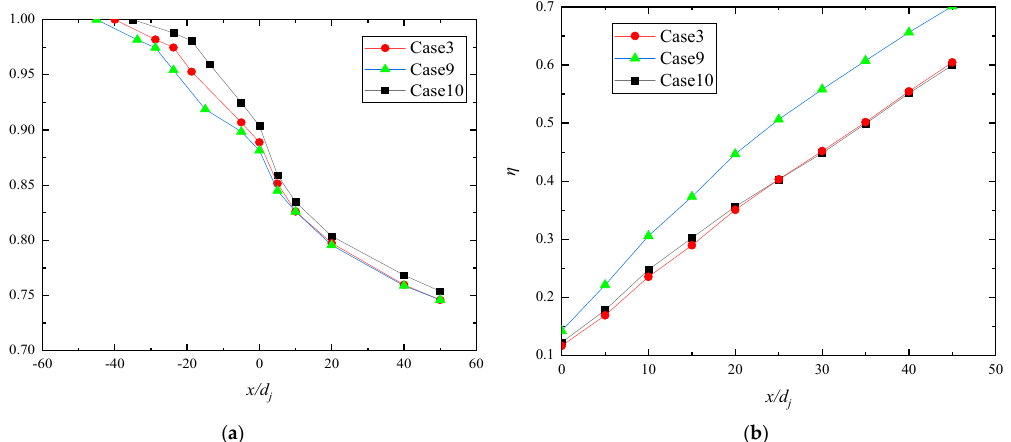
Figure 17. Comparison of mixing parameters along the flow direction of Case3, Case9, and Case10. ( a ) Total pressure recovery coefficient. ( b ) Mixing efficiency. As for the fuel penetration depth, the influence of the angle of SWG and oblique shock position is mainly studied on the data in Case3, Case5, Case7, Case9, and Case10. In terms of fuel penetration depth, the angle of SWG is changed based on the unilateral setting of the SWG. In Figure 18a,b, the penetration depth of Case7 is the largest, and the penetration depth of Case3 and 5 was the same. In Figure 18c,d, the impact of the shock wave interacting position on fuel penetration depth is as follows: at the lower wall surface, the penetration depth of Case10 is the largest before x/d j = 20, while that of Case9 is the largest after x/d j = 20. Case3, Case9, and Case10 are the same near the upper wall. In terms of fuel penetration depth, the change of angle of SWG influences fuel penetration depth.